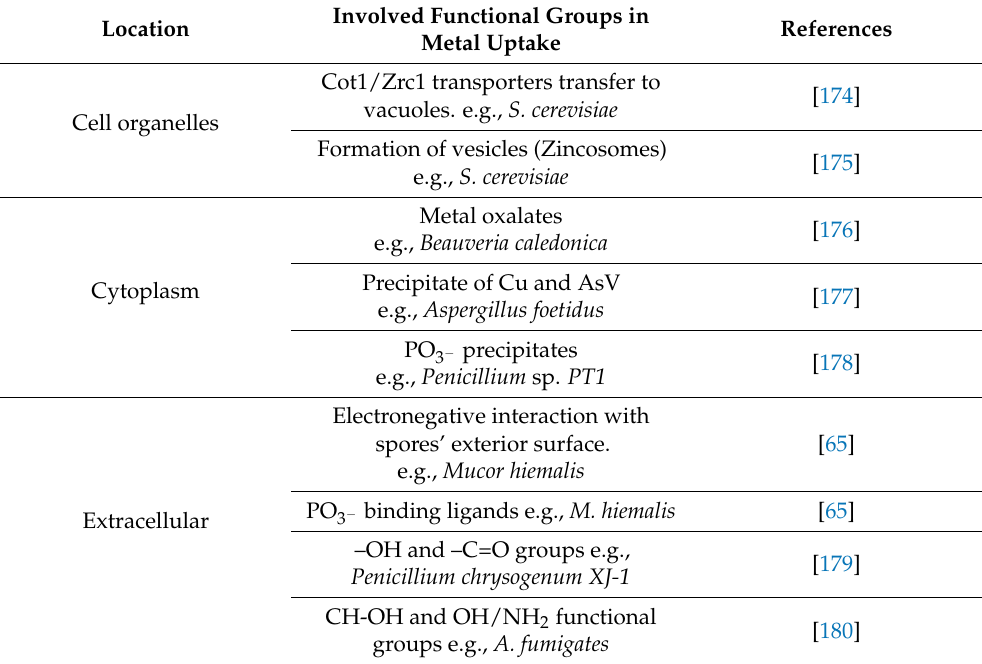
Table 2. Toxic metals binding to fungal cells are aided by many cellular